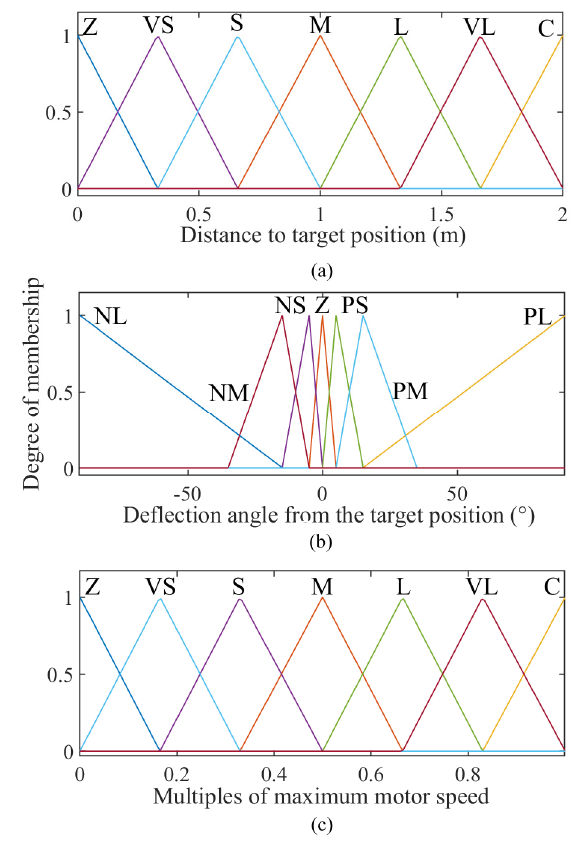
Figure 5. Membership functions of linguistic variables for mobile robot’s: ( a ) distance D from target position; ( b ) deviation δ from target position; ( c ) multiples of maximum speed of right k wR and left k wL motor.